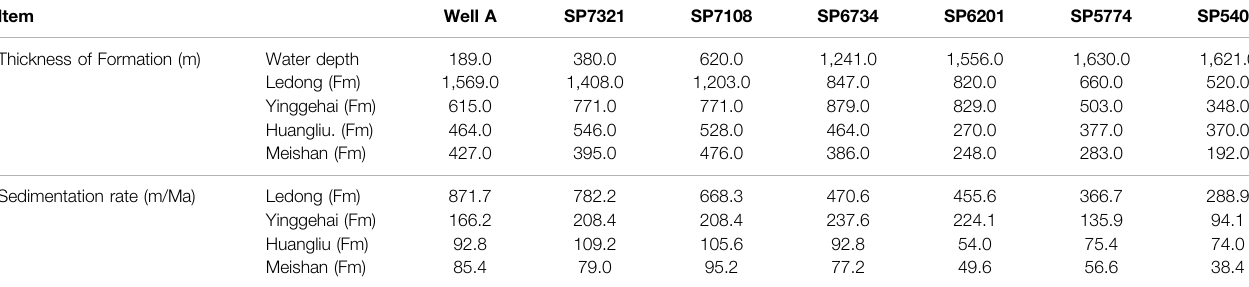
TABLE 2 | Sedimentation rates for the various formations and positions. Item